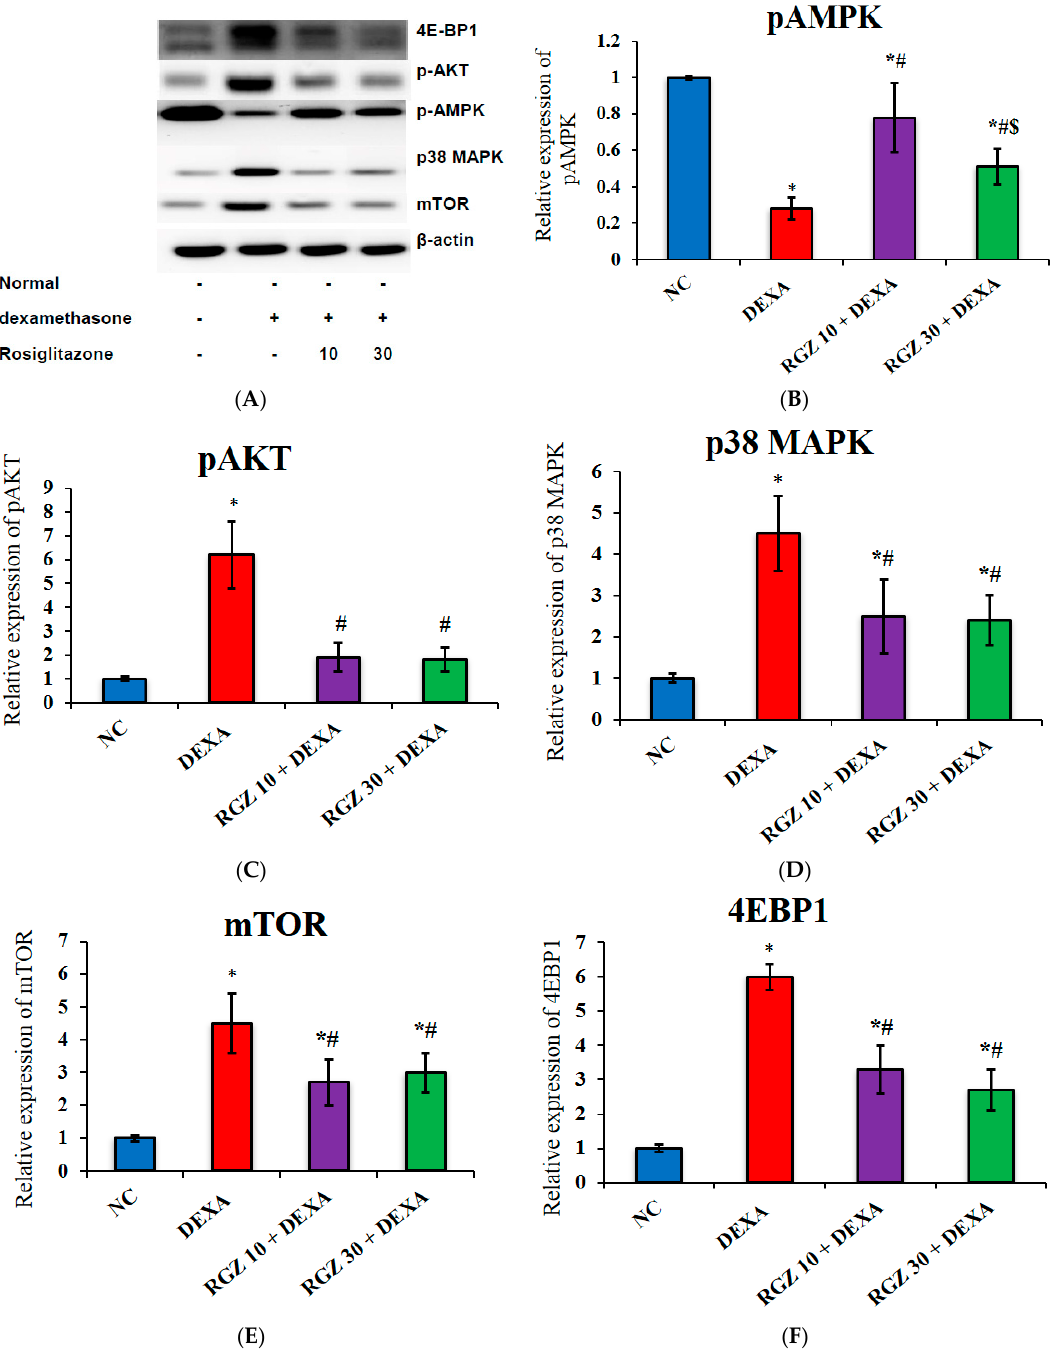
Figure 4. Western blot bands (A) representing the analysis of the Expression of ( B ) pAKT, ( C ) pAMPK- α , ( D ) p38MAPK, ( E ) mTOR, and ( F ) 4EBP1 in hippocampus and frontal cortex tissue of mice. The statistical evaluation was conducted by a one-way ANOVA and then Tukey’s post hoc test. Values are represented by the mean ± SD ( n = 8). NC—normal control; DEXA—dexamethasone; RGZ—rosiglitazone; pAMPK—Adenosine monophosphate-activated protein kinase; pAKT—pro- tein kinase B; p38MAPK—mitogen-activated protein kinases; mTOR—mammalian target of ra- pamycin complex; 14EBP1—eukaryotic initiation factor 4E (eIF4E)-binding proteins. A significant difference was considered at p < 0.05 and distinguished by * vs. NC; # vs. DEXA; $ vs. RGZ 10 mg/kg. A significant difference in pAMPK levels was detected in the different groups ( F 3,31 = 70, p < 0.001). In comparison to the normal control group, DEXA significantly reduced the expression of pAMPK at Thr172 in the hippocampus and frontal brain by 72% ( p < 0.001). Contrarily, administration of RGZ at a dose of 10 or 30 mg/kg for 21 days resulted in a significant increase in pAMPK at Thr172 by 64%, p < 0.001, and 45%, p = 0.001, respectively, compared with the untreated group ( p < 0.001) (Figure 4B and Table S4). Likewise, a significant difference was observed in the expression of pAKT at Ser473 ( F 3,31 = 29.7, p < 0.001) and p38MAPK at Thr180/Tyr182 ( F 3,31 = 38.6, p < 0.001) between the different groups. A post hoc analysis showed that DEXA significantly increased pAKT at Ser473 and p38MAPK at Thr180/Tyr182 by 83% and 77%, respectively ( p < 0.001), as com- pared with the normal control group. Compared with the positive control (untreated) group, administration of 10 or 30 mg/kg RGZ significantly reduced pAKT at Ser473 by